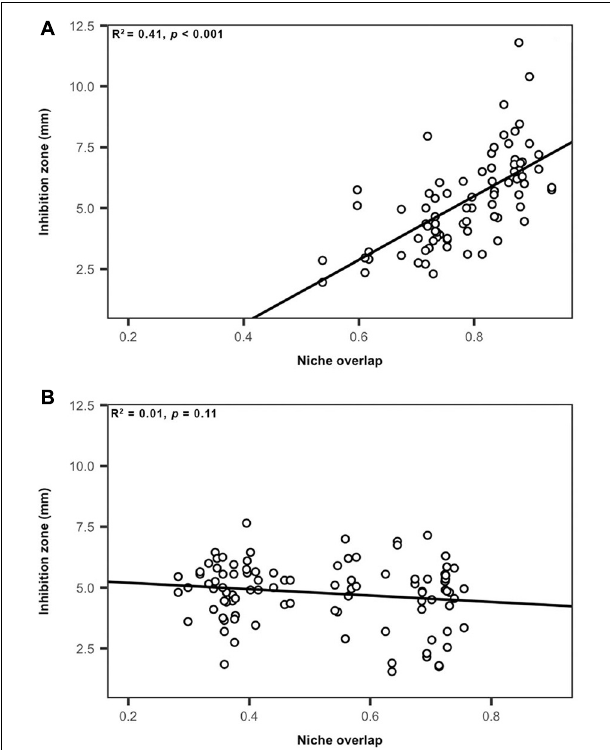
FIGURE 5 | Relationship between nutrient use and intensity of inhibition among Streptomyces isolates from carbon-amended and non-amended soils. (A) Streptomyces isolates from carbon-amended soils that were inhibitory against isolates from non-amended soils, (B) Streptomyces isolates from non-amended soils that were inhibitory against isolates from carbon-amended soils. Each circle represents the relationship between niche overlap and inhibition zone size (mm) corresponding to individual source Streptomyces isolates that were inhibitory to target Streptomyces isolates (A) 81, inhibitory interactions, (B) 97, inhibitory